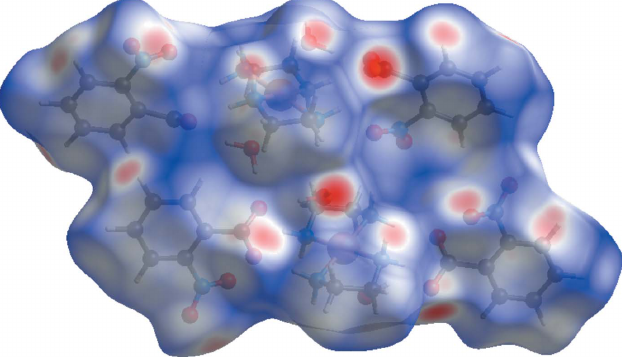
Figure 4 Hirshfeld surface fingerprint plots for the O (cid:2)(cid:2)(cid:2) H/H (cid:2)(cid:2)(cid:2) O, H (cid:2)(cid:2)(cid:2) H and C (cid:2)(cid:2)(cid:2) H/H (cid:2)(cid:2)(cid:2) C contacts of the title